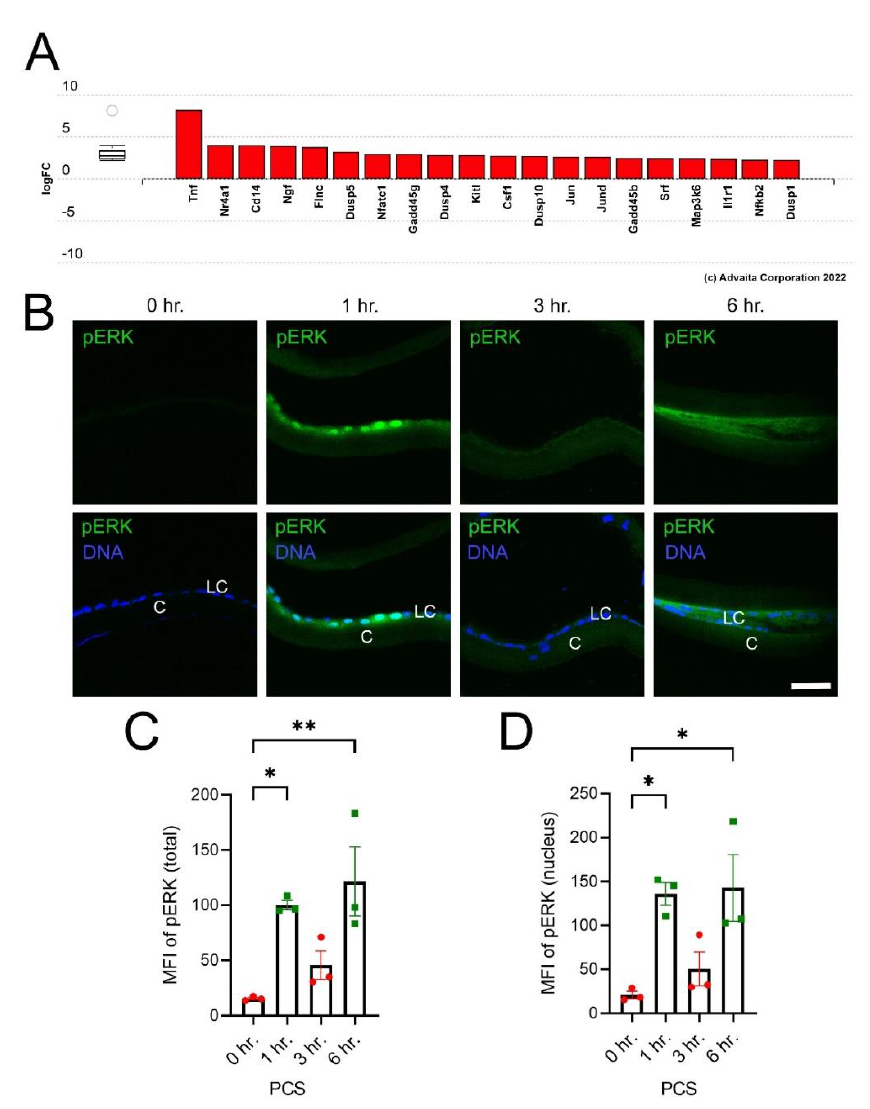
Figure 2. MAPK signaling is acutely activated in LECs after lens injury ( A ) Bar graph of Advaita iPathway analysis of genes differentially expressed in LECs at 6 h PCS associated with MAPK signaling. ( B ) Immunostaining of pERK1/2 (green) in LECs isolated either immediately after lens fiber cell removal (0 h) or 1, 3 or 6 h later. Blue represents DNA. Scale bar = 35 µ m ( C ) Quantitiation of total pERK1/2 levels in LECs obtained from three independent biological replicates ( D ) Quantitation of nuclear pERK1/2 levels in LECs obtained from three biological replicates. * represents p ≤ 0.05; ** represents p ≤ 0.01. The red dots and green squares in C & D both represent the individual biological replicate values for their corresponding bar in the bar